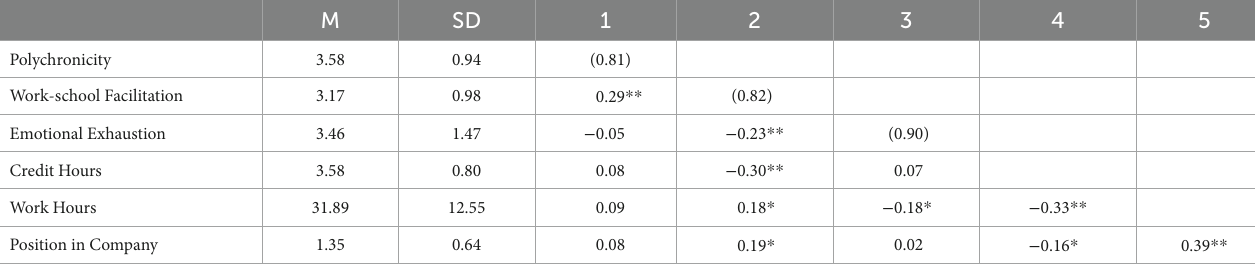
TABLE 1 Descriptive statistics and correlation